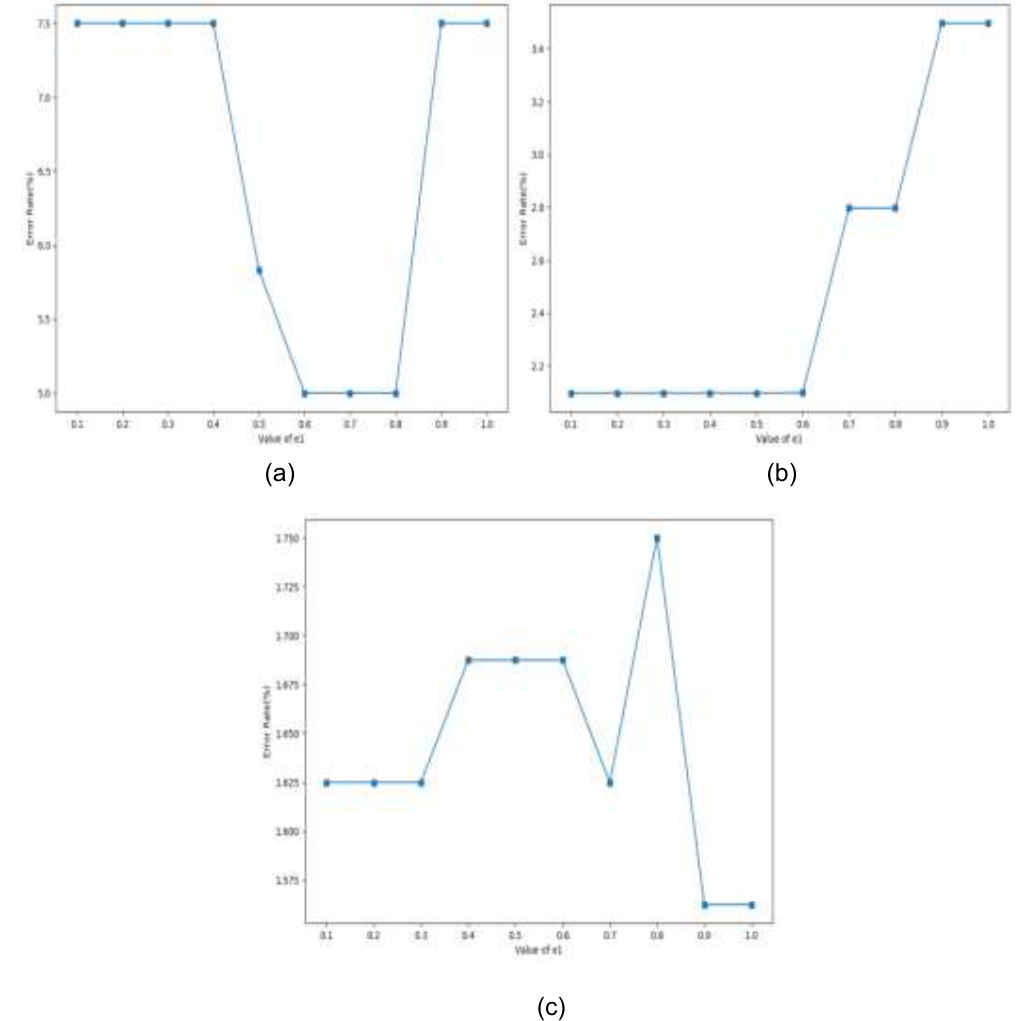
Figure 4. Impact of e1 in terms of error rate on Real data (a) Iris (b) Wine (c) Wireless Indoor